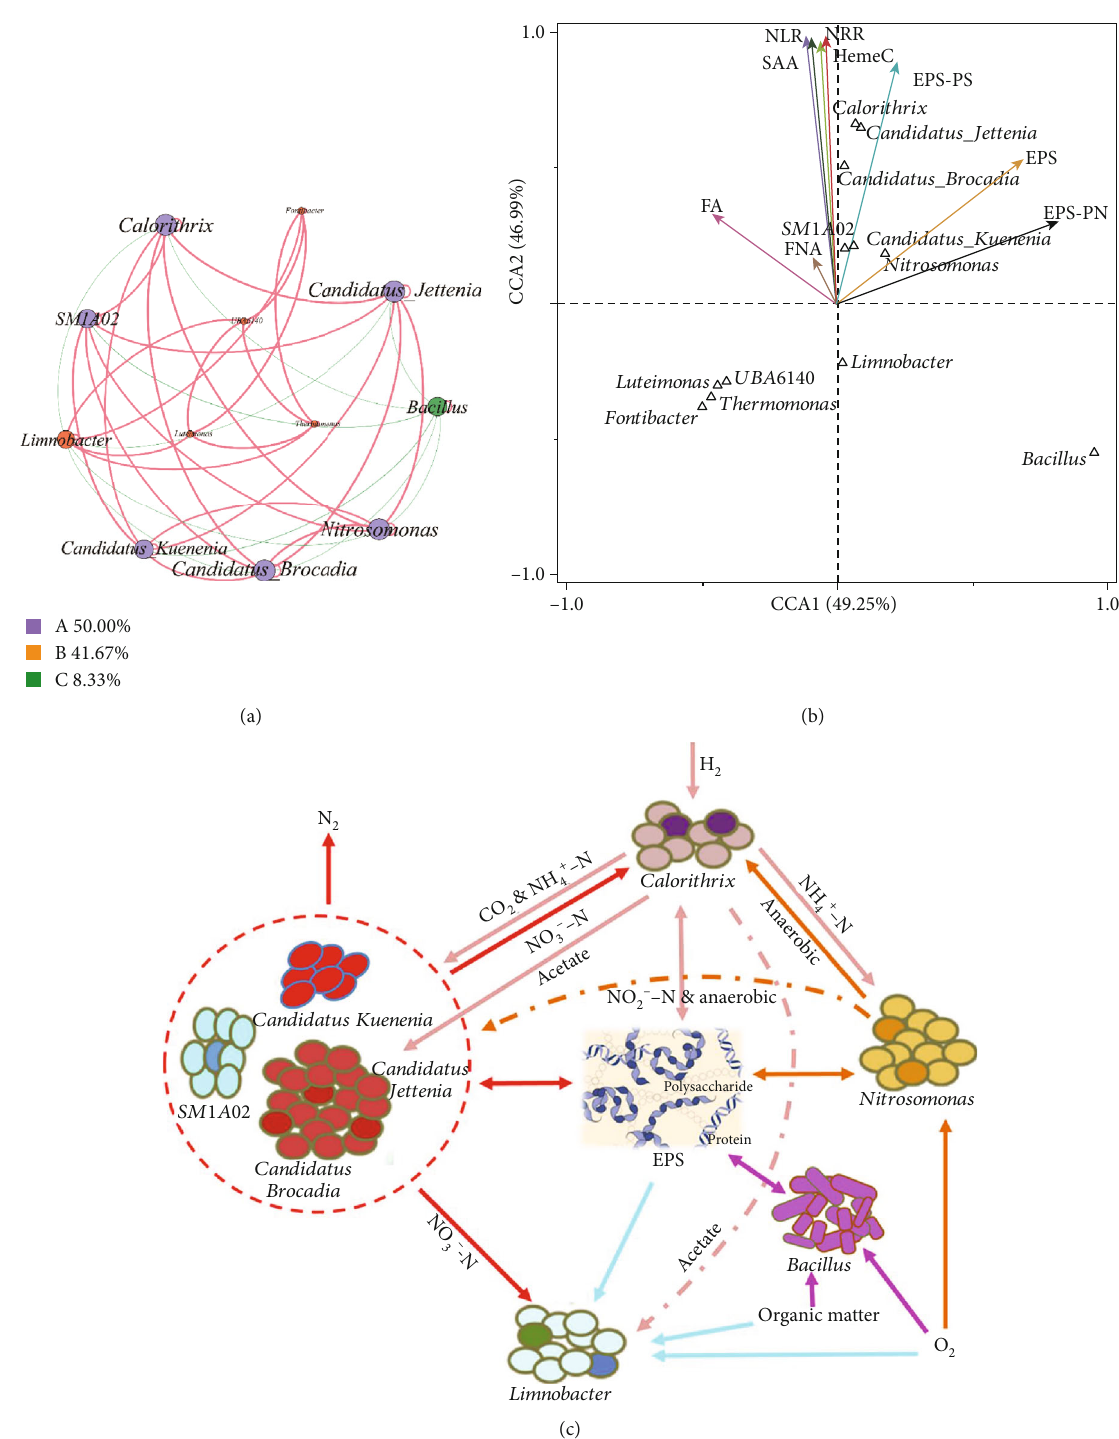
Figure 5: (a) Cooccurring network analysis of dominant micro fl ora, (b) CCA of microbial communities and the in fl uencing factors, and (c) correlation among dominant micro fl ora, in the CANON process exposed to alkaline shock. The cooccurring network is coloured by the modularity class. Each node represents a dominant genus. Red and green lines represent positive and negative correlations, respectively. Node sizes are weighted by the node degree (numbers of